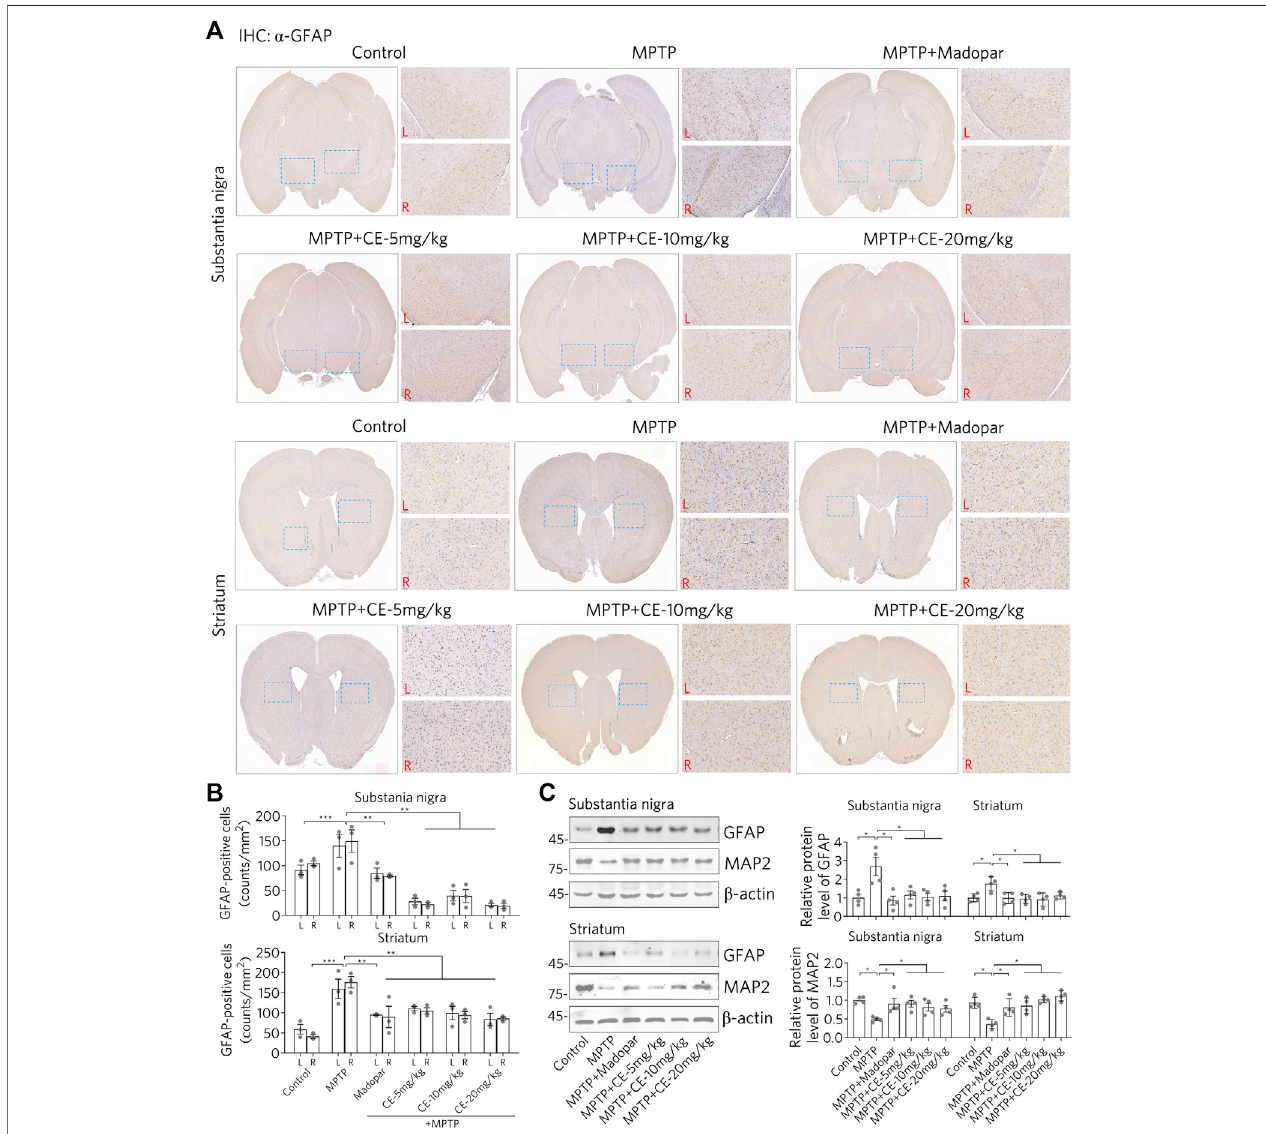
FIGURE 3 | CE attenuates astrocyte activation and protects neurons from MPTP-induced toxicity. (A) IHC staining of GFAP-positive cells in substantia nigra and striatum. (B) Counts of TH-positive cells, n = 3. (C) Western blotting of GFAP and MAP2 proteins. Relative protein levels were examined according to the density of blotted bands and normalized to β -actin, n = 4. One-way ANOVA, post hoc Dunnett ’ s test was performed to verify the signi fi cance of differences between groups.